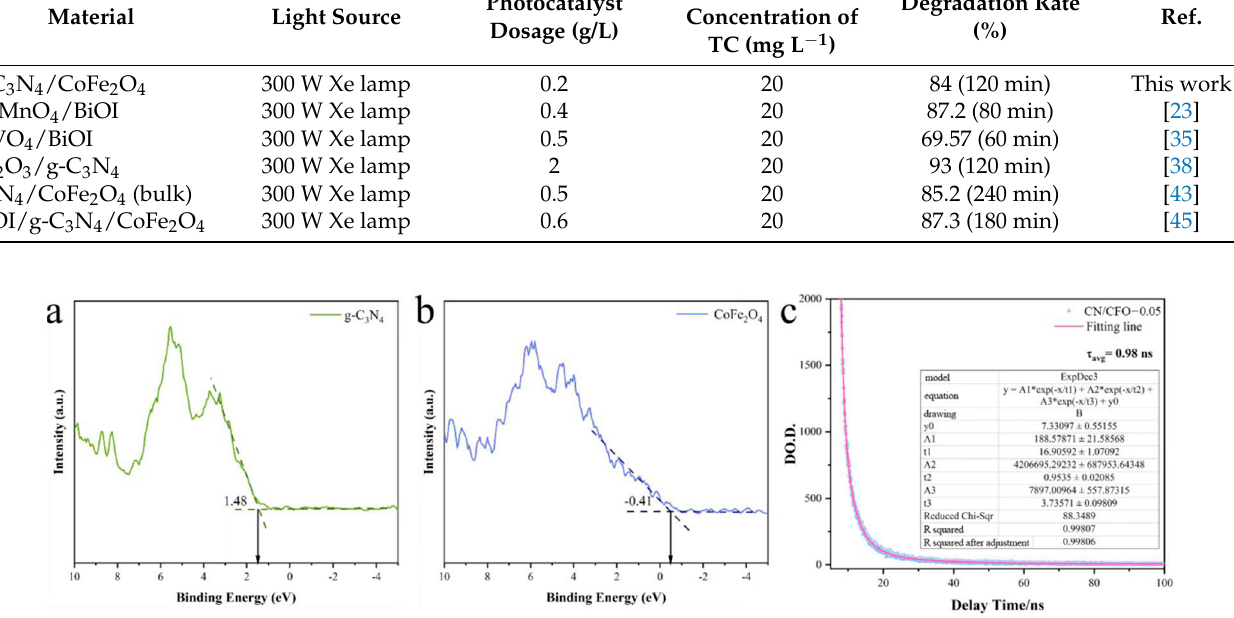
Figure 6. Valence band positions of CN, CFO ( a , b ); transient fluorescence lifetime of CN/CFO-0.05 ( c ). The calculated ECB values for CFO and CN were − 1.81 and − 1.24 eV,